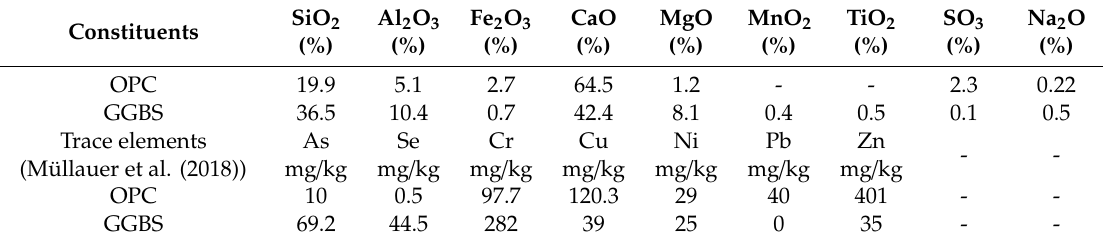
Table 2. Typical constituents of ground granulated blast furnace slag (GGBS) and ordinary Portland cement (OPC).